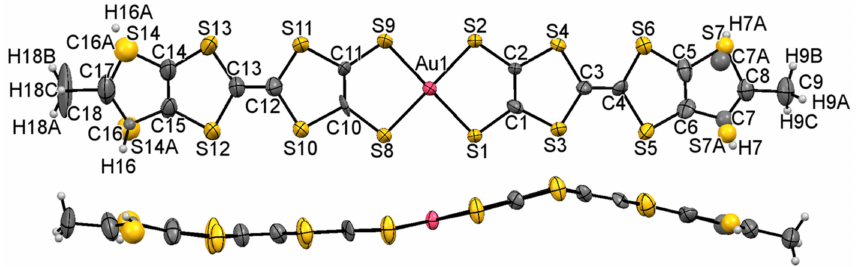
Figure 1. ORTEP and atomic numbering schemes (top and side views) of [Au( α -mtdt) 2 ] monoanion in the crystal structure of ( n -Bu 4 N)[Au( α -mtdt) 2 ] ( 3 ), with thermal ellipsoids drawn at 50% probability